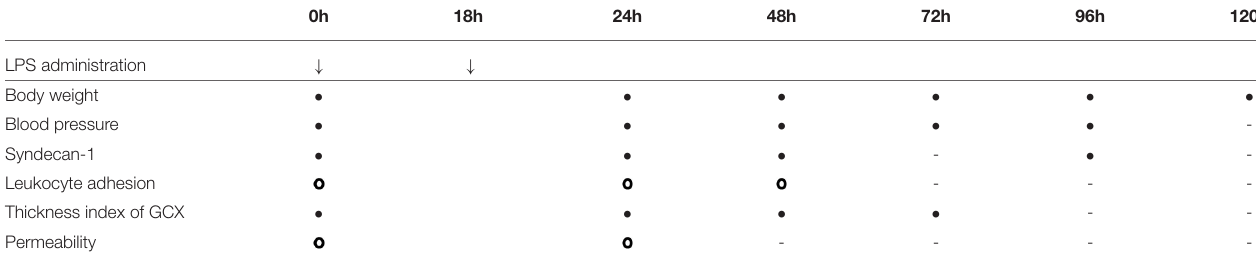
TABLE 1 | Overview of the experimental protocol. 0h 18h